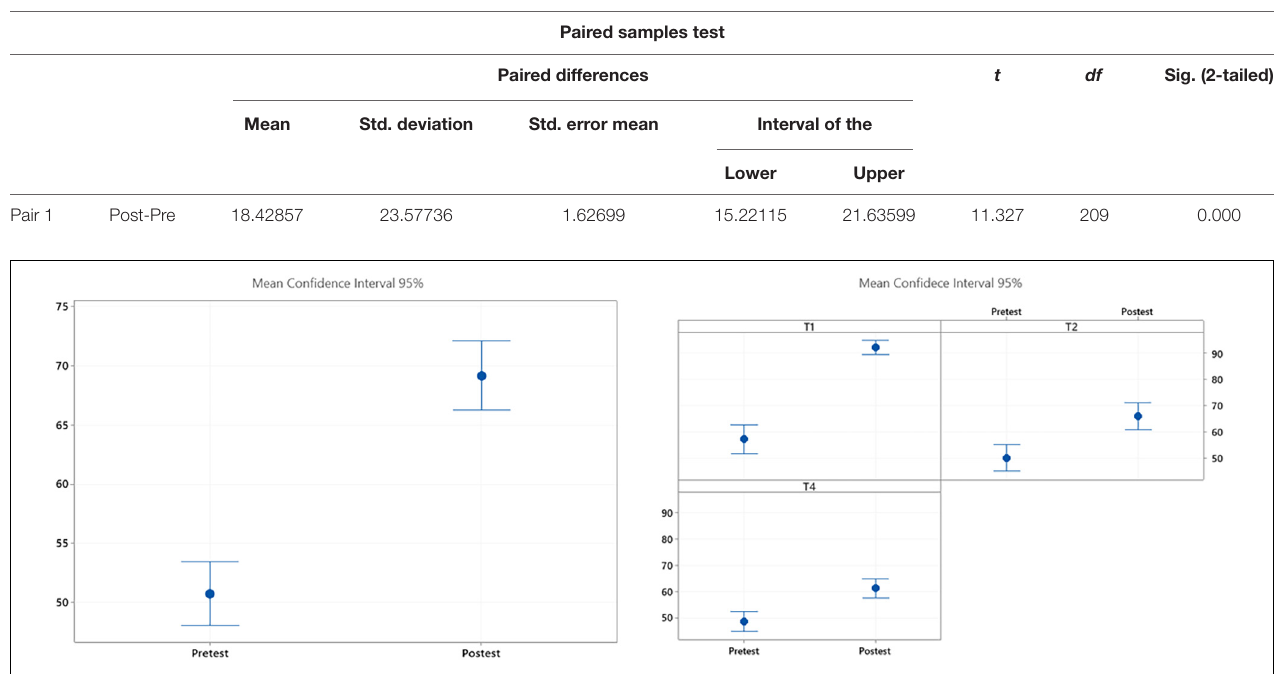
TABLE 5 | Paired mean differences sample test between pre and post-tests in the second activity.